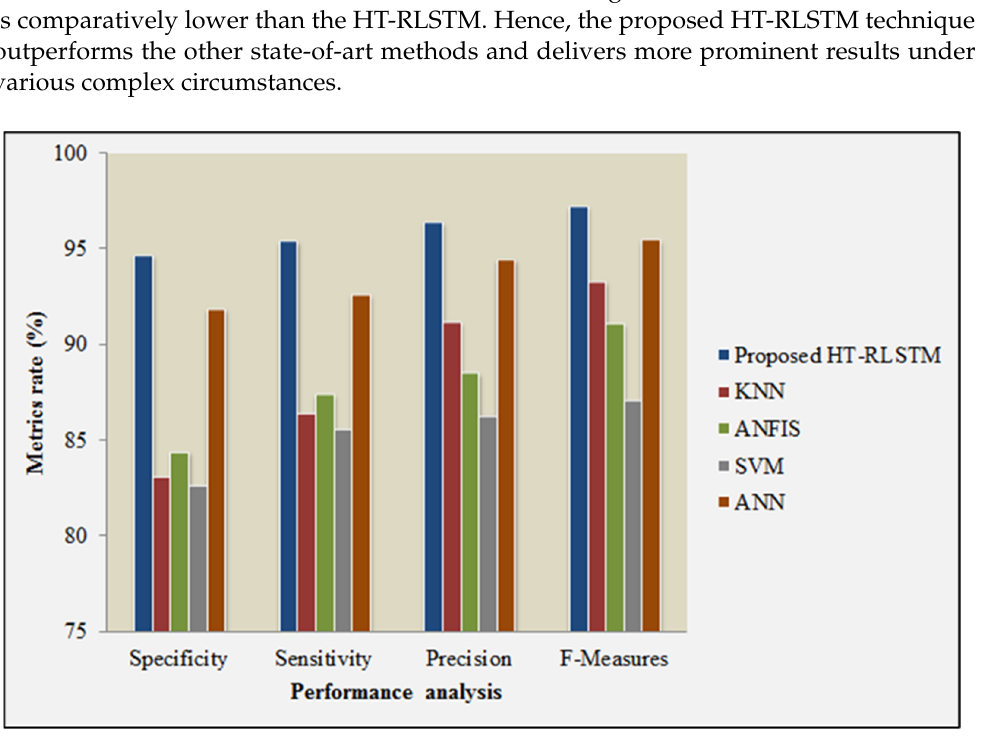
Figure 4. Comparative analysis of the proposed HT-RLSTM based on specificity, sensitivity, precision, and recall.